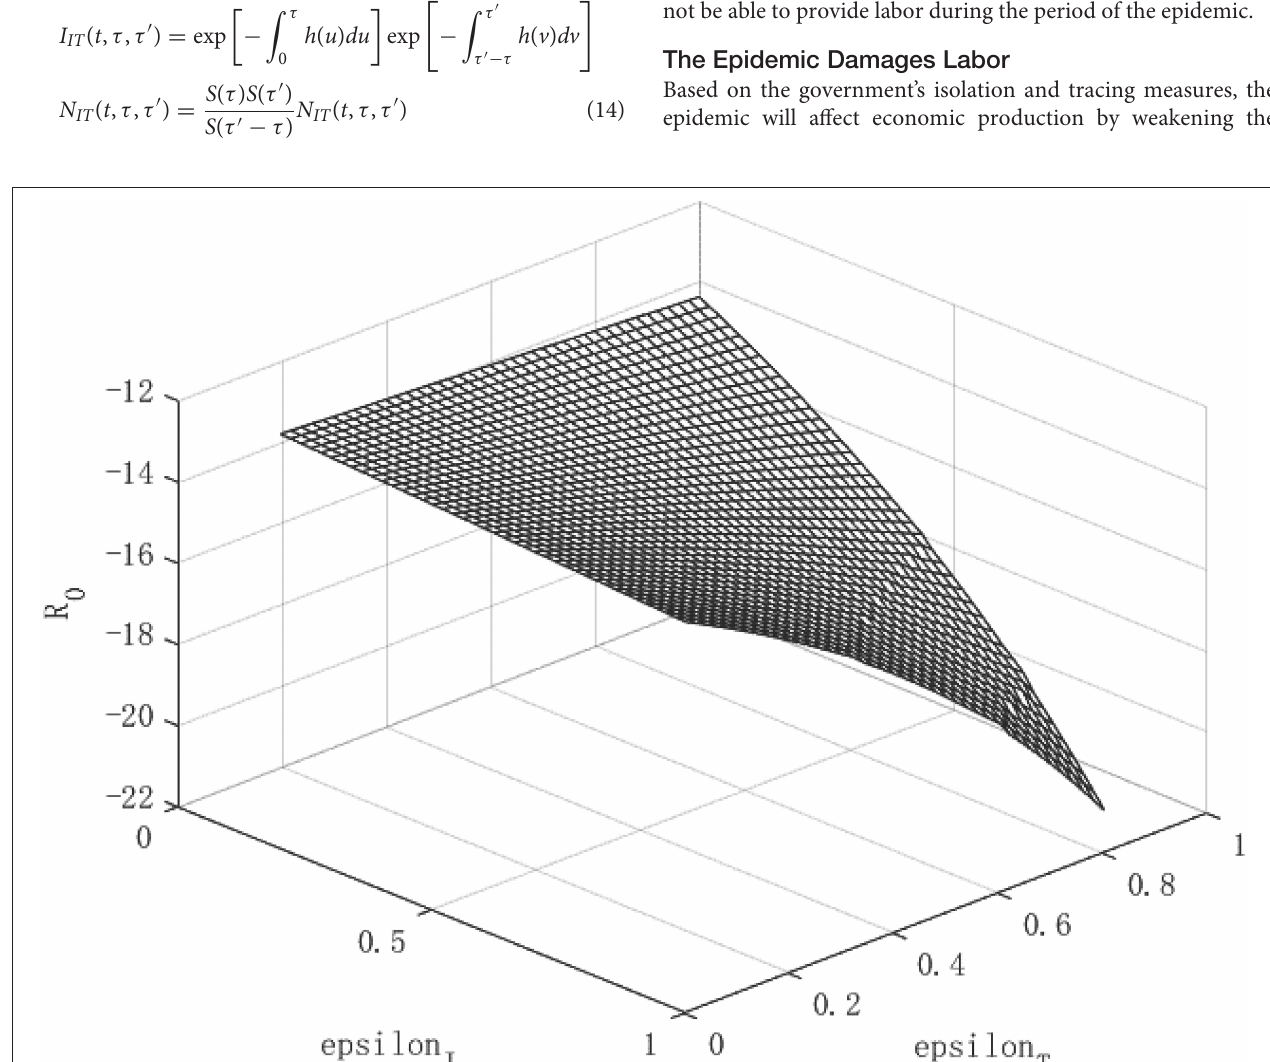
FIGURE 4 | Virus Transmission Path of low contagious public health